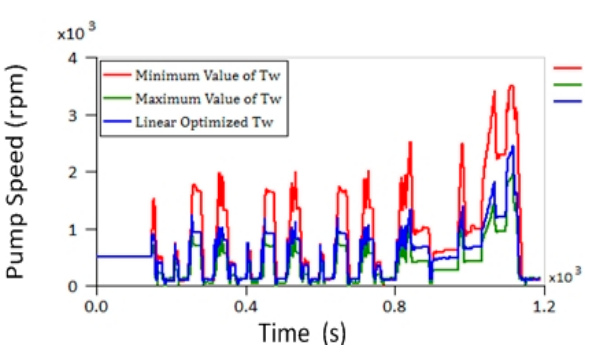
Figure 22. Comparison of the pump speed.